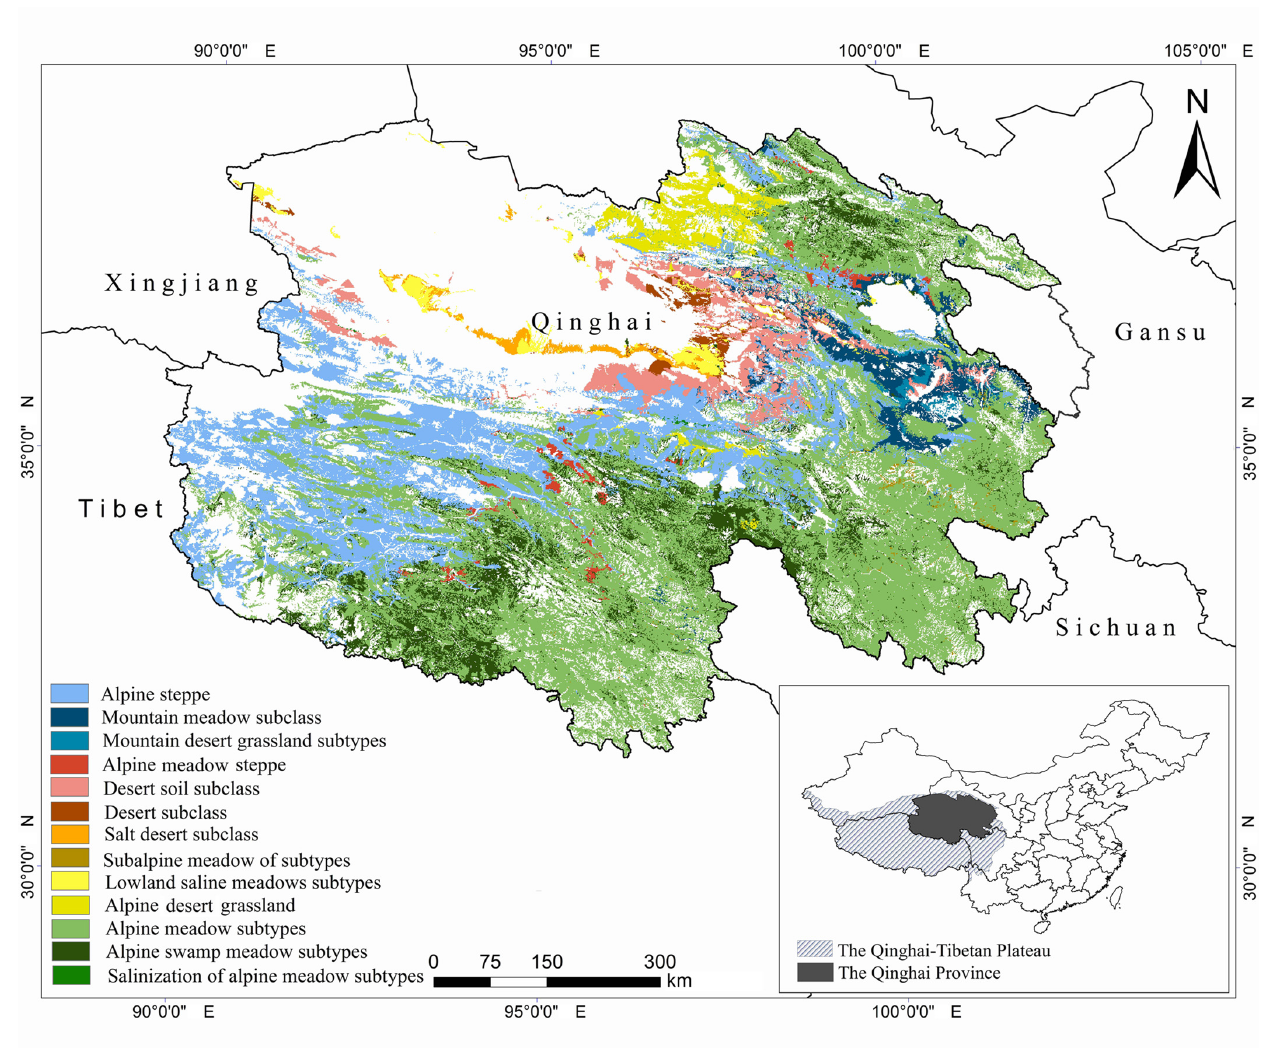
Figure 1. Location of the study area and spatial distribution of the main grassland types. White areas are not covered by grassland.